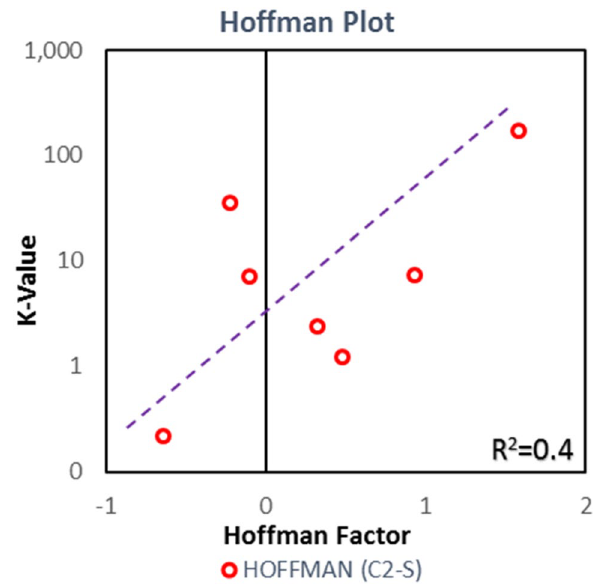
Fig. 18 Invalid Hoffman plot—recombination test